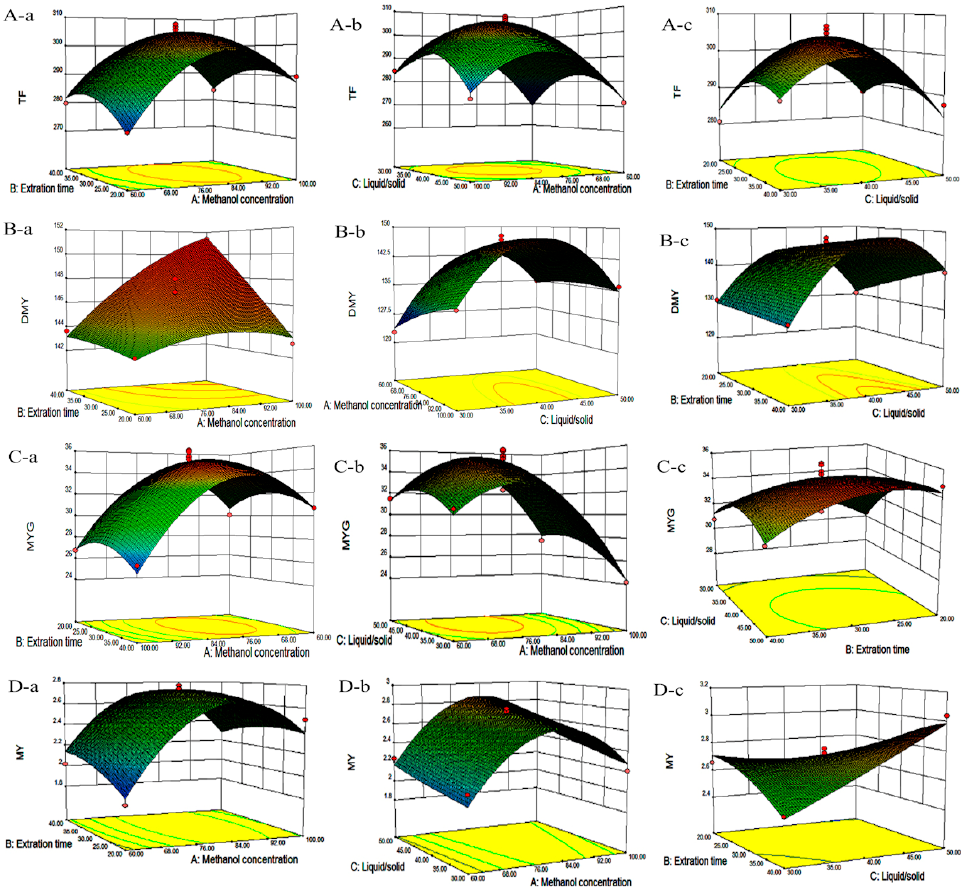
Figure 2. Response surface plots and contour plots show the effects of ( a ) methanol concentration and extraction time, ( b ) methanol concentration and liquid-solid and ( c ) extraction time and liquid-solid on the response of the amounts of total flavonoids ( A ), dihydromyricetin ( B ), myricitrin ( C ) and myricetin ( D ).